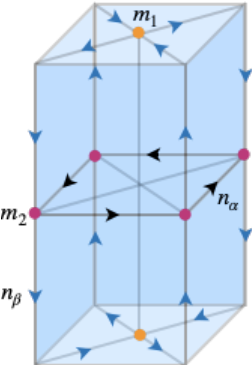
Figure 8: An illustration of a state with a fully gapped bulk a surface containing an ˜ R symmetric configuration of chiral majorana modes and majorana zero-modes. 4 z The hinges with blue and black arrows contain n α and n γ majorana modes while the orange and red dots denote the presence of m